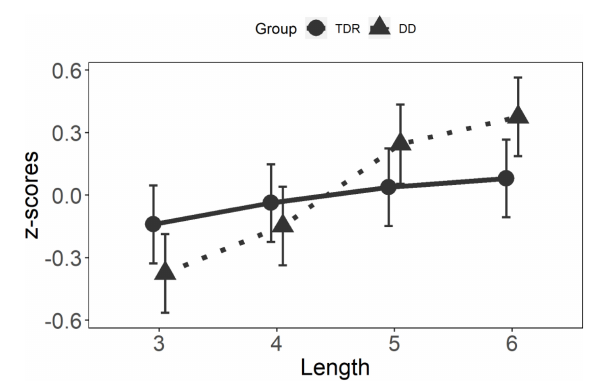
FIGURE 5 | Two-way interaction on z -scores on non-words. Higher z -scores reflect lower performance. TDR, typical developing readers and DD, developmental dyslexics.